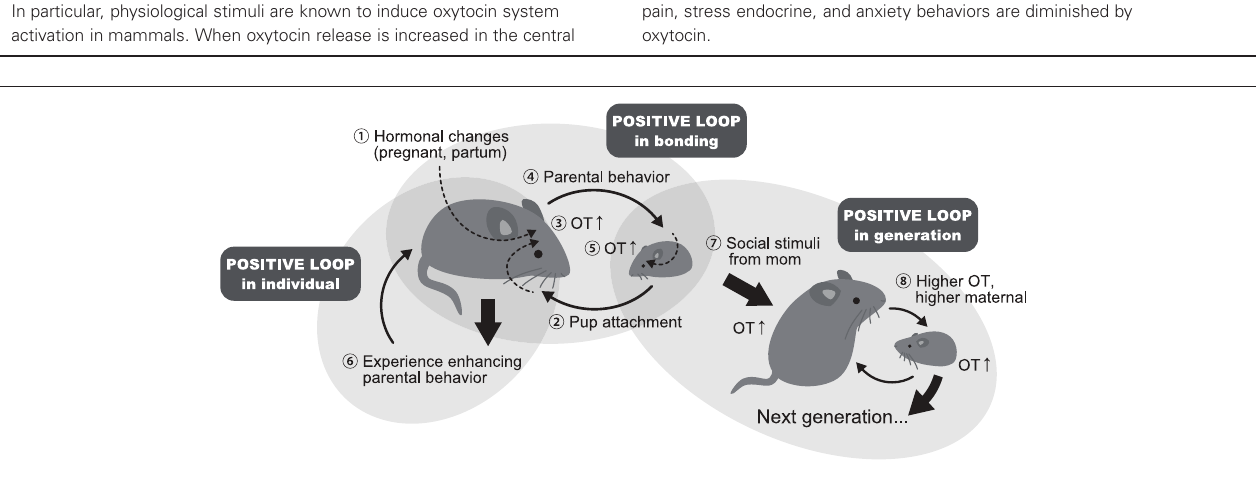
FIGURE 2 | A schematic illustrating the positive loop of social bonding controlled by oxytocin. The mother mouse becomes pregnant and then at partum, certain hormonal changes occur (1). After delivery, new-born infants show attachment behavior toward the mother (2). The hormonal changes related to partum and attachment behavior from the infant stimulate the release of centrally acting oxytocin (OT) (3). OT in the maternal brain facilitates parenting behavior toward the pups (4). This parenting behavior